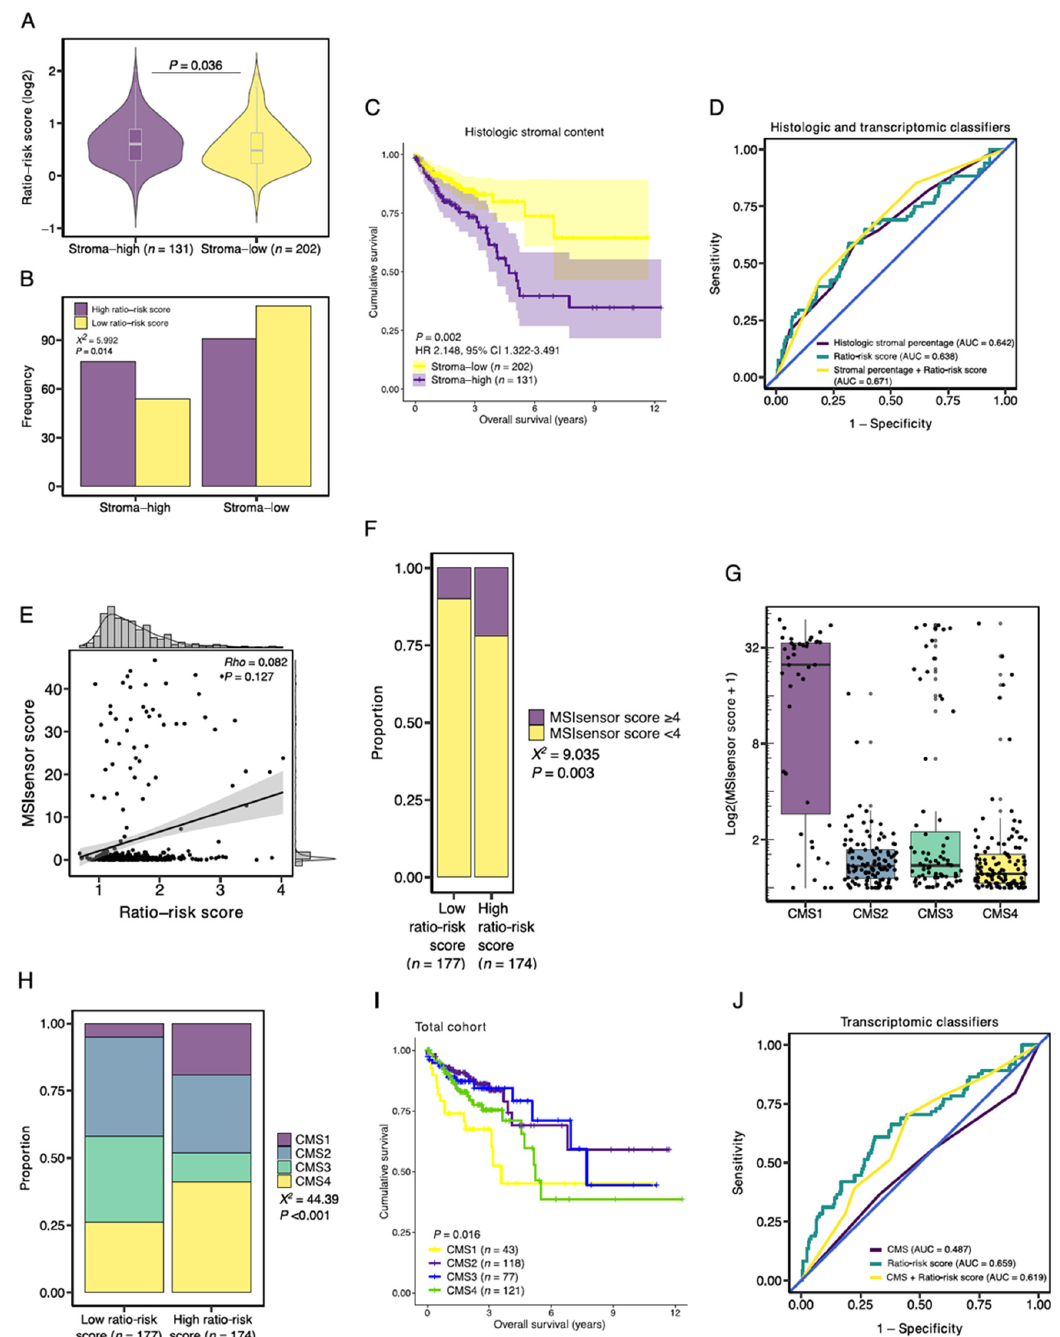
Figure 7. Association of the stromal-epithelial signature ratio with established histologic and molecular tumor characteristics. ( A ) Median ratio-risk score for the stroma-high and stroma-low populations as categorized by the TSR. ( B ) Frequency barplot for high and low ratio-risk scores stratified by the TSR. ( C ) Kaplan-Meier curve of the overall survival for the histologic stroma-high and stroma-low tumors. ( D ) Prognostic performance of histologic intratumoral stromal percentage and the ratio-risk scores. ( E ) Correlation between the continuous MSIsensor scores and ratio-risk scores. ( F ) Proportion of MSIsensor scores in the high and low-ratio risk score tumors. ( G ) MSIsensor scores and consensus molecular subtypes (CMS). ( H ) Proportion of consensus molecular subtypes (CMS) in the high and low-ratio risk score tumors. ( I ) Kaplan-Meier curve of the overall survival for the CMS. ( J ) Prognostic performance of the CMS and the ratio-risk scores. AUC, area under the curve; X 2 , Pearson Chi-Square; Rho, Spearman’s rho.